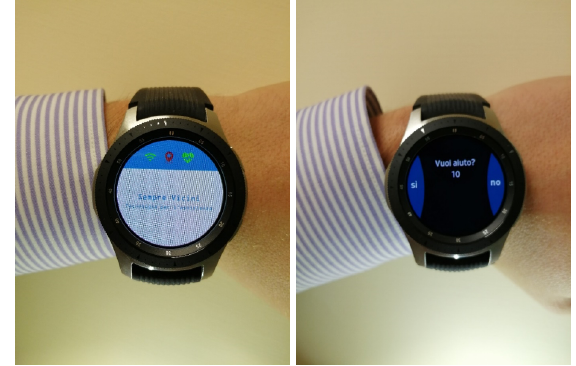
Figure 2. The Assisto eCare 4.0 smartwatch